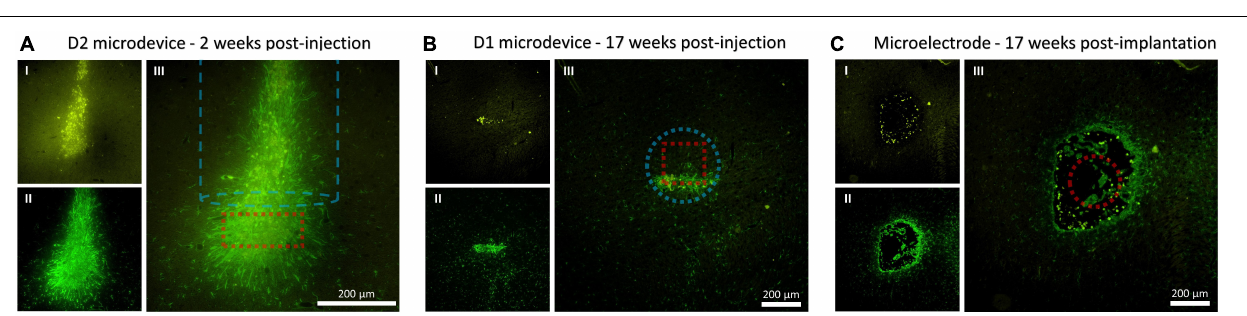
FIGURE 4 | Tracking microdevice migration in the rodent brain using a 9.4T MRI scanner. ( Top row ) Two axial MR images of the rat (#3) brain taken at different post-injection times and one axial MR image created by superimposing one over the other. The microdevice was injected (encircled in yellow) in the right hemisphere. ( Bottom row ) Two coronal MR images of the rat (#5) brain taken at different post-injection times and one axial MR image created by superimposing one over the other. The microdevice was injected (encircled in yellow) in the left hemisphere. The right hemisphere shows a tethered microelectrode. Images II show a close-up of the microdevice taken from images I, and images III show a close-up view of the microdevice with subtraction done instead of superimposition.